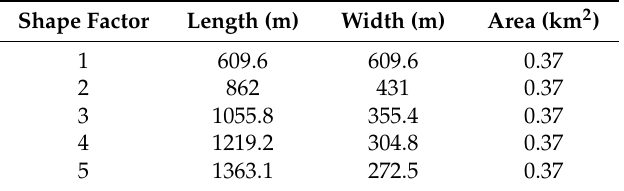
Table 1. Rectangular basin dimensions and shape factor (length vs.